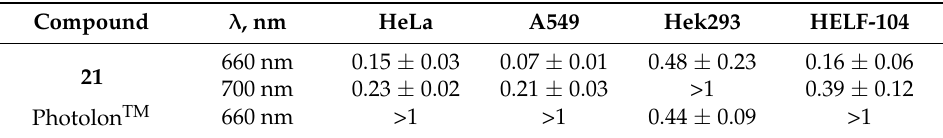
Table 2. The values IC 50 ± SE ( μ M) for photoinduced cytotoxicity of Compound 21 and the drug Photolon TM in the experiments in vitro.